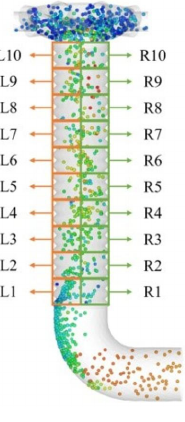
Figure 6. Schematic diagram of the division of the left and right sides of the vertical pipe. As shown in Figure 7, as the height of the corrugated tube and the smooth tube increased, the mass ratio of the particles distributed on both sides of the tube gradually tended toward 1. However, compared with the smooth tube, the corrugated tube could converge L/R to around 1 in a shorter length. It could be seen that the corrugated tube had certain advantages in uniformly distributing particles on both sides of the tube.